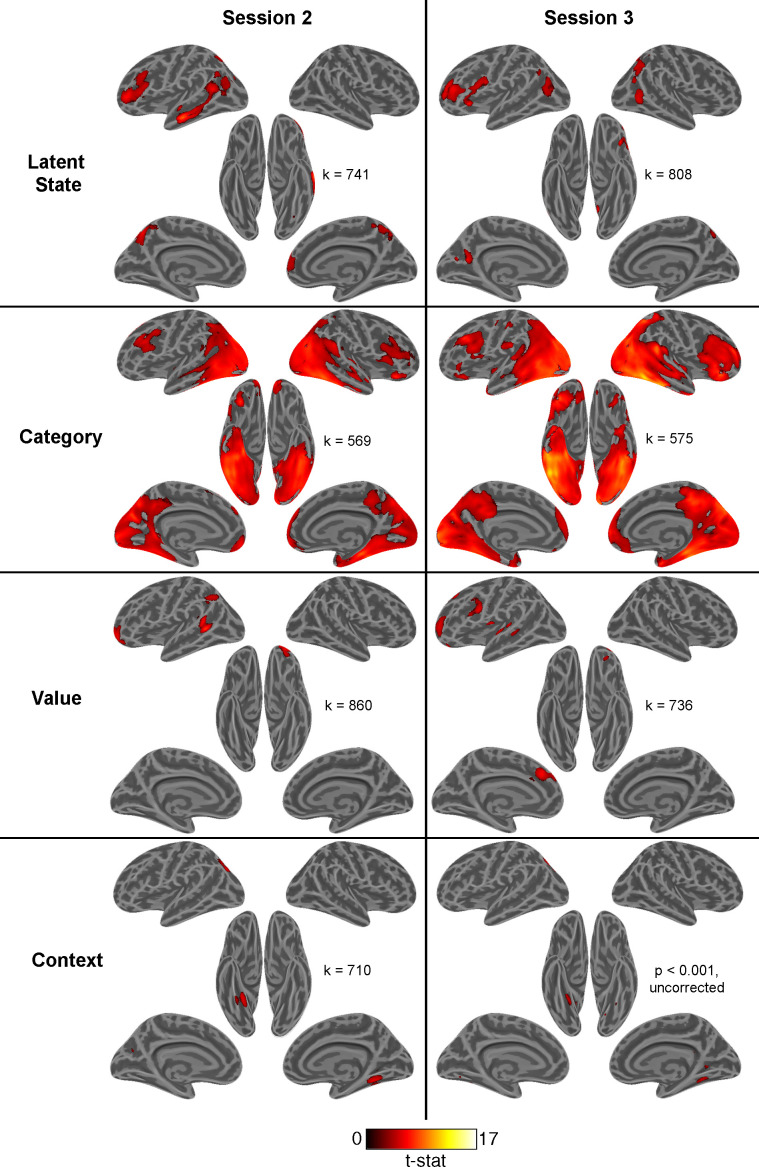
Statistical maps for main effects of multiple regression model from searchlight representational similarity analyses (RSAs) estimated separately for data from sessions 2 and 3 and projected onto inflated cortical surfaces.All statistical maps were thresholded with a cluster forming threshold of p<0.001 and corrected for multiple comparisons using permutation tests to find a cluster extent threshold (k) at p<0.05, except for the context effects in session 3 where no clusters passed this threshold (these data are shown at p<0.001, uncorrected).